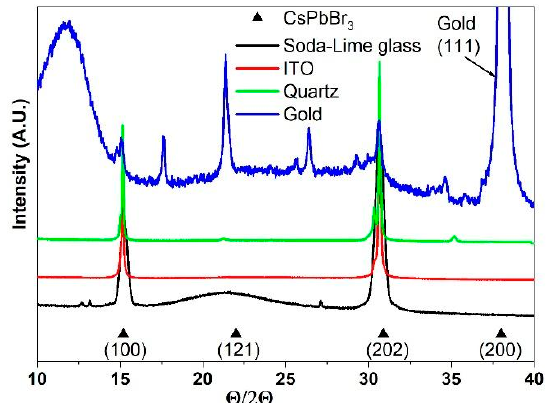
Figure 1. X-ray diffraction (XRD) patterns of the “as-deposited” thin films. Full triangles indicate the CsPbBr 3 phase diffraction peaks.